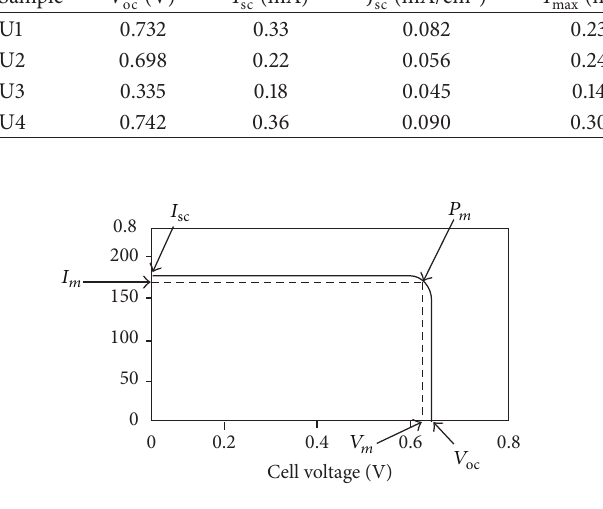
Figure 13: 𝐼 - 𝑉 characteristics of a typical DSC [20].